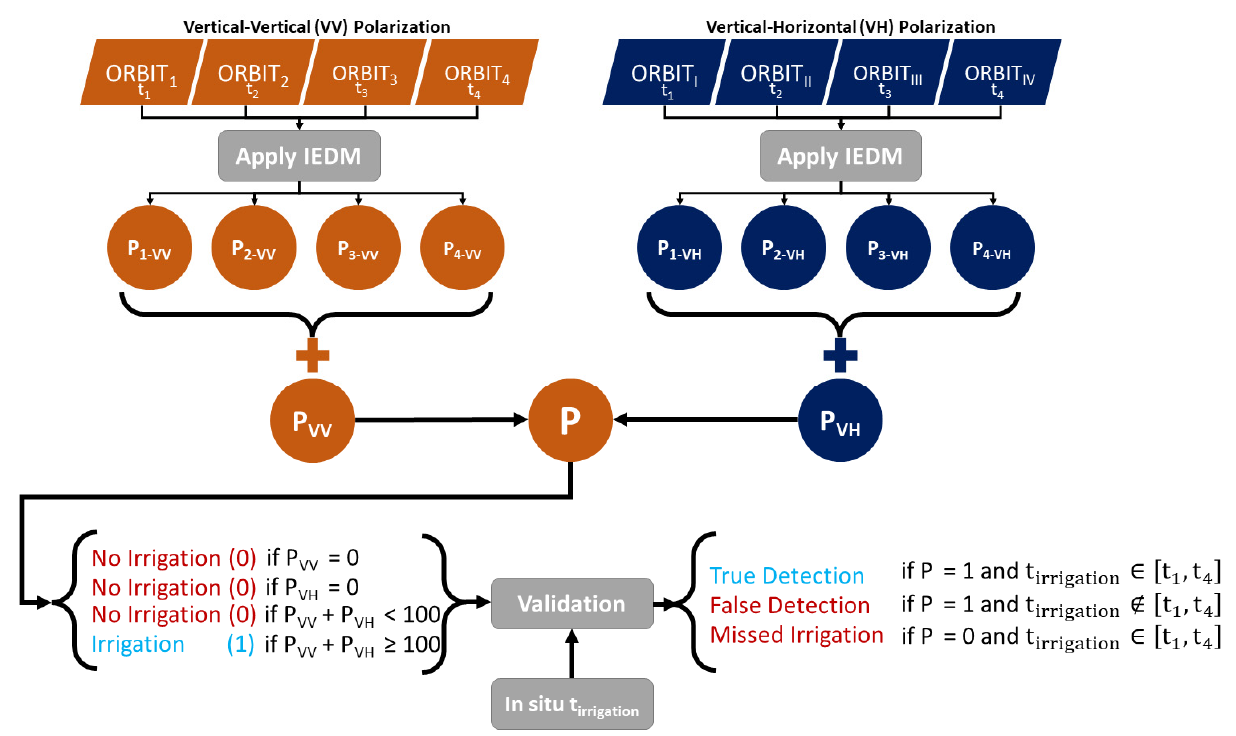
Figure 2. Flowchart of the application of IEDM and the combination of the irrigation likelihood for each group of S1 images originating from different orbits in a six-day interval; t 1 , t 2 , t 3 and t 4 correspond to the maximum dates of the 4 S1 images in a 6-day time interval and t irrigation corresponds to the in situ registered irrigation date.